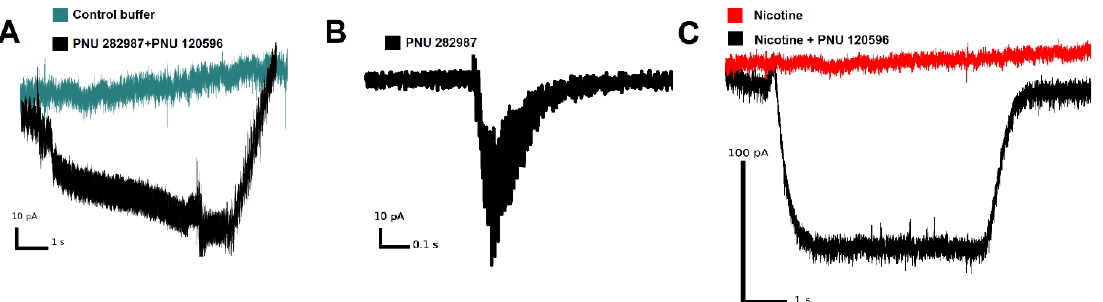
Figure 4. Patch-clamp experiments on THP-1M φ . Representative traces for ( A ) bu ff er (green line) or 1 µ M PNU 282,987 with 10 µ M PNU 120,596 (black line), ( B ) 1 µ M PNU 282,987, and ( C ) 10 µ M nicotine (red line) or 10 µ M nicotine with 10 µ M PNU 120,596 (black line), which have been applied to the cells.